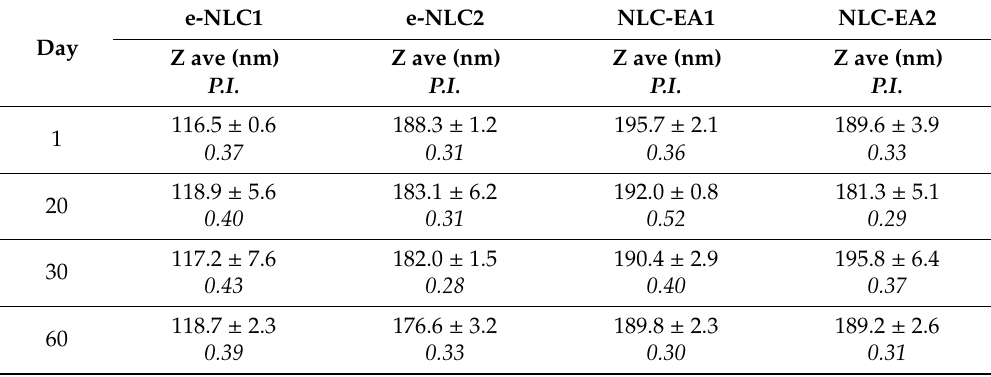
Table 3. Mean diameters of NLCs as determined by photon correlation spectroscopy (PCS).